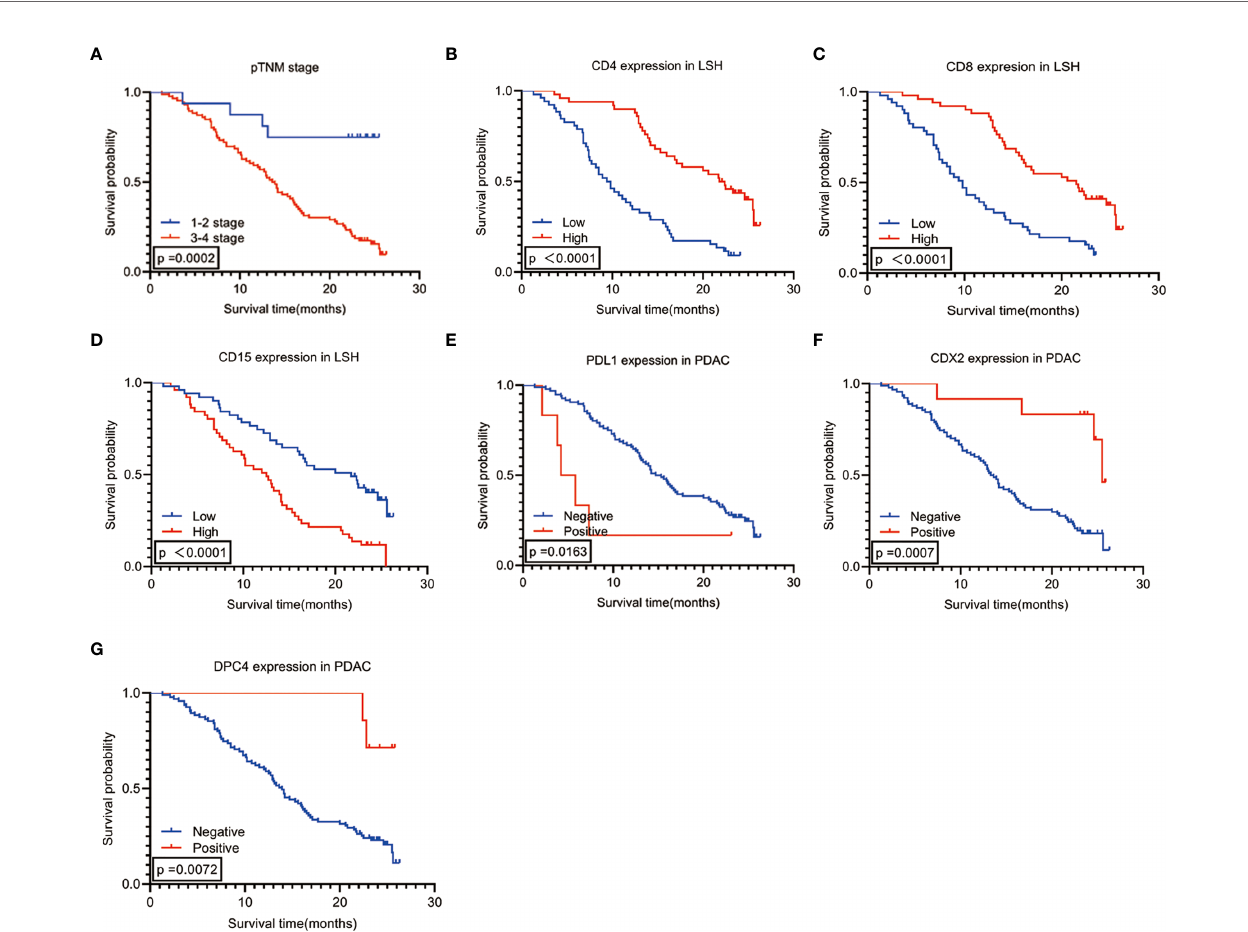
FIGURE 2 | Kaplan-Meier survival analysis curves according to 7 (A – G) variables that were signi fi cantly associated with PDAC prognosis. PDAC, pancreatic ductal